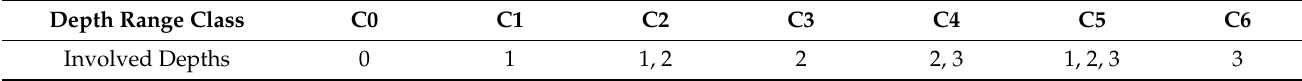
Table 3. The depth sets and their involved